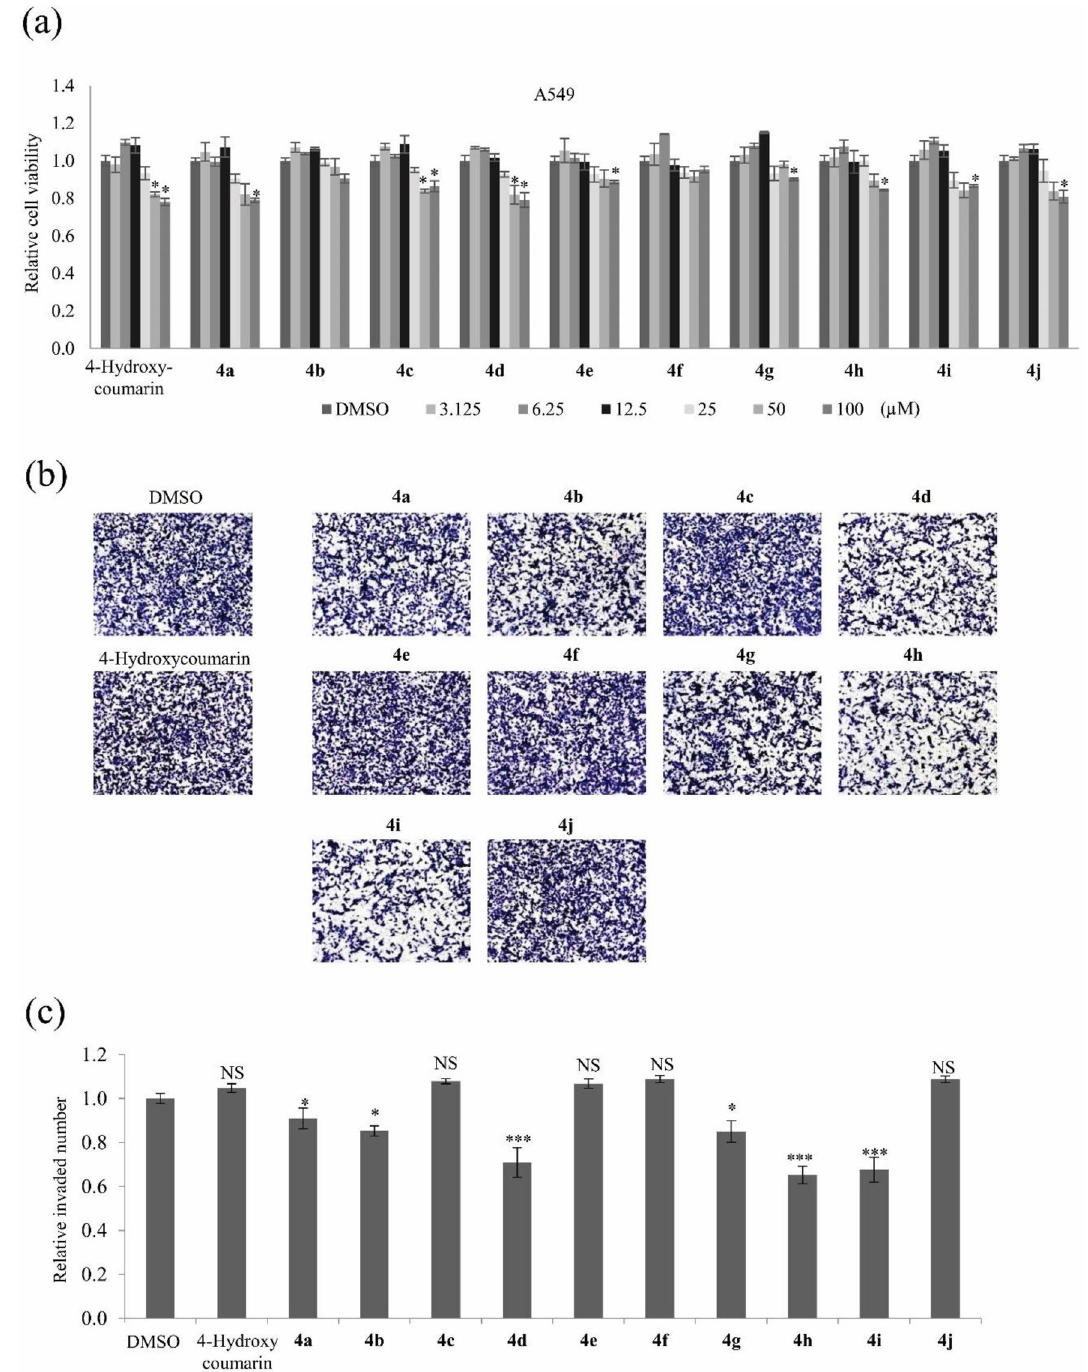
Figure 3. The effects of 4-hydroxycoumarin and its derivatives 4a – 4j on invasion of A549 cells. ( a ) Relative viabilities of A549 cells after treatment with 4-hydroxycoumarin and its derivatives 4a – 4j for 48 h at concentrations ranging from 3.125 to 100 μM measured by the MTT assay. ( b ) Representative images of invasion assays of A549 cells treated with 4-hydroxycoumarin and its derivatives 4a – 4j at a concentration of 5 μM. ( c ) Quantitative analysis of invaded cell numbers after each treatment. Representative images from three independent experiments are shown (n = 3). Data represent the mean ± SD. * p < 0.05; *** p < 0.001; NS, no significant difference compared with dimethyl sulfoxide (DMSO)-treated A549